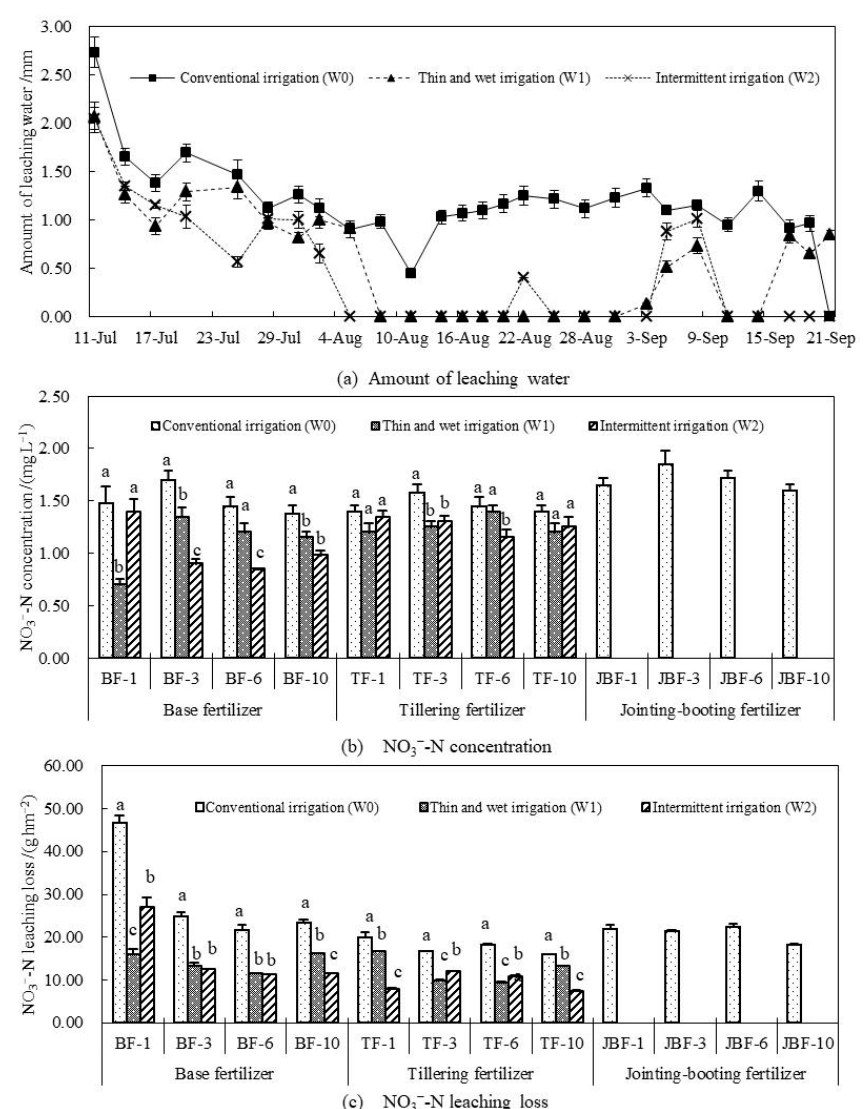
Figure 1. Changes of leakage amount, concentration, and leaching loss of NO 3 − -N during rice growth under different irrigation patterns, Figure a described the changes of leakage amount, Figure b described the changes of NO 3 − -N concentration and Figure c described changes of NO 3 − -N leaching loss. (BF-1, BF-3, BF-6, BF-10 represented the 1th, 3rd, 6th, and 10th days after the application of base fertilizer, a, b and c in the figure represented differences between groups for significance